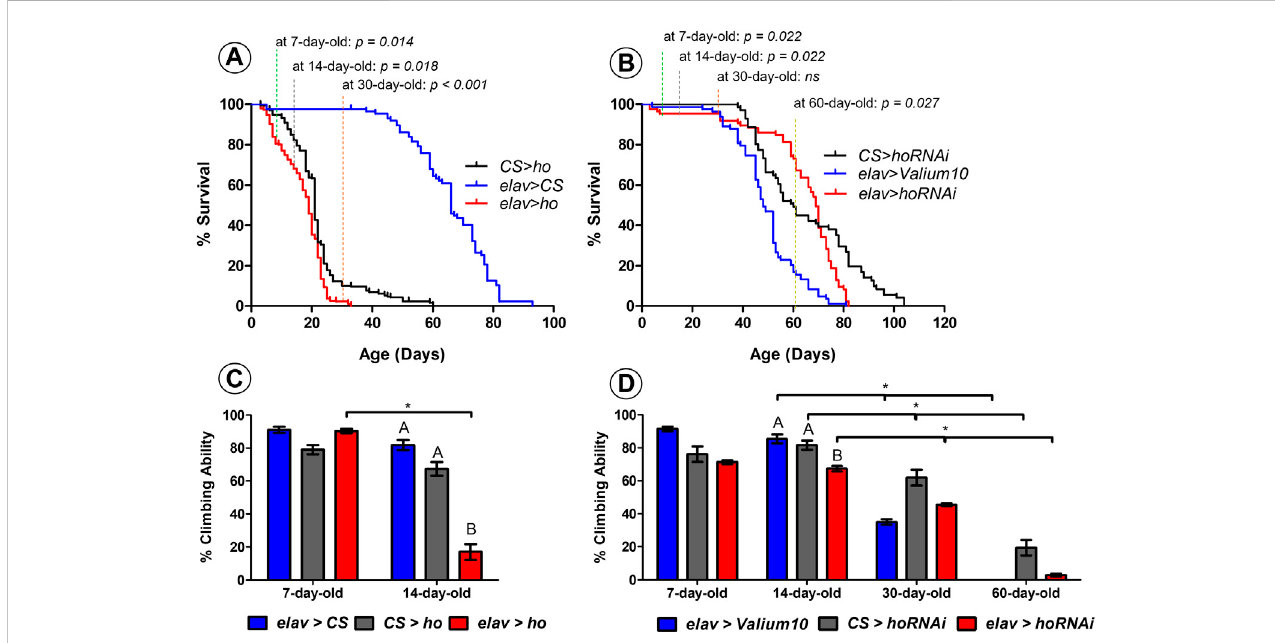
FIGURE 1 Neuronal ho expression level is important for the survival and climbing ability of Drosophila . Percentage of survival for fl ies with pan-neuronal ho overexpression (A) was signi fi cantly different than parental controls in 7-, 14-, and 30- day-old fl ies (non-parametric ANOVA Kruskal – Wallis and post hoc Conover-Imantests; p valuesareindicated);whereas,forpan-neuronal ho silencing (B) ,differencesinpercentageofsurvivalwerestatisticallysigni fi cantin7-, 14-,and 60-day-old fl ies(non-parametricANOVA Kruskal – Wallisand posthoc Conover-Imantests; p values areindicated).For percentage ofclimbing ability which is shown as means ± SEM (C – D) , statistically signi fi cant differences between genotypes are indicated with different letters (after 14 days for ho overexpressionand ho silencingaswell;non-parametricANOVAKruskal – Wallisand posthoc Conover-Imantests: ho overexpression p =0.024, ho silencing p = 0.050) and asterisks between different age groups (non-parametric Mann-Whitney test: 7 days vs. 14 days for elav > ho p = 0.050, 14 days vs. 30 days for elav > Valium10 p = 0.050, CS > hoRNAi p = 0.050 , elav > hoRNAi p = 0.038; 14 days vs. 60 days for elav > Valium10 p = 0.032, CS > hoRNAi p = 0.050 , elav > hoRNAi p = 0.050). Each assay was repeated at least three times with 30 fl ies per genotype in each